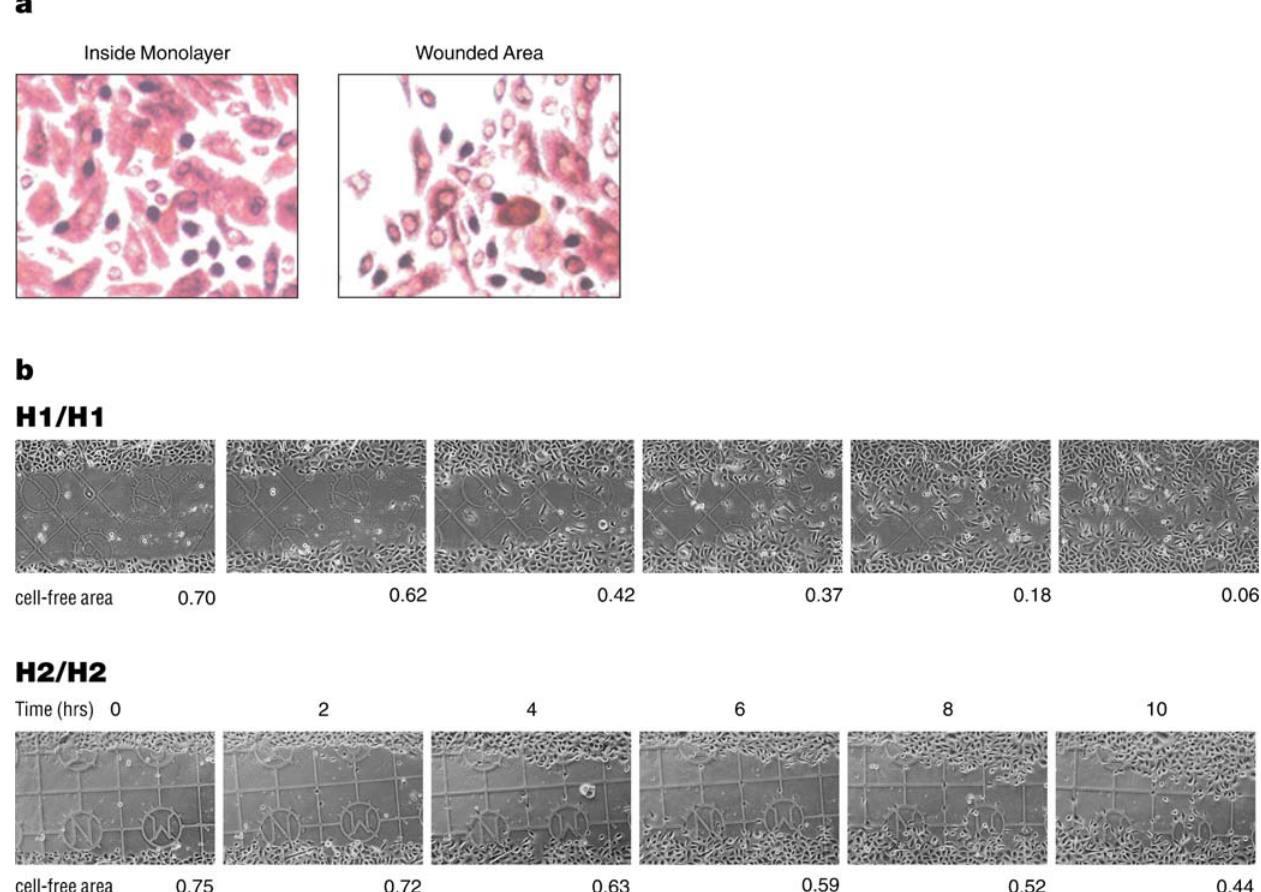
Figure 3. Wound assay. a. HEK cells were stained with BrdU five hours after wounding. The number of BrdU-positive cells observed at the wound area was roughly equal to the number observed within the monolayer (98 6 6), indicating that the two areas had approximately the same amount of cell proliferation. b. Migration of HEK cells in response to wounding. Digital photographs taken at the same positions at the time-points indicated show the migration of HEK cells into the cell-free areas of the artificial wound sites. Examples from cell-lines homozygous for KRT1 haplotype patterns H1 and H2 are shown. The cell-free areas are given as a fraction of the 638 m m 6 956 m m area shown (the visible grid-lines are 175 m m apart). The cell- free areas from eight replicates are used to calculate the migration rate of each sample (see Methods).